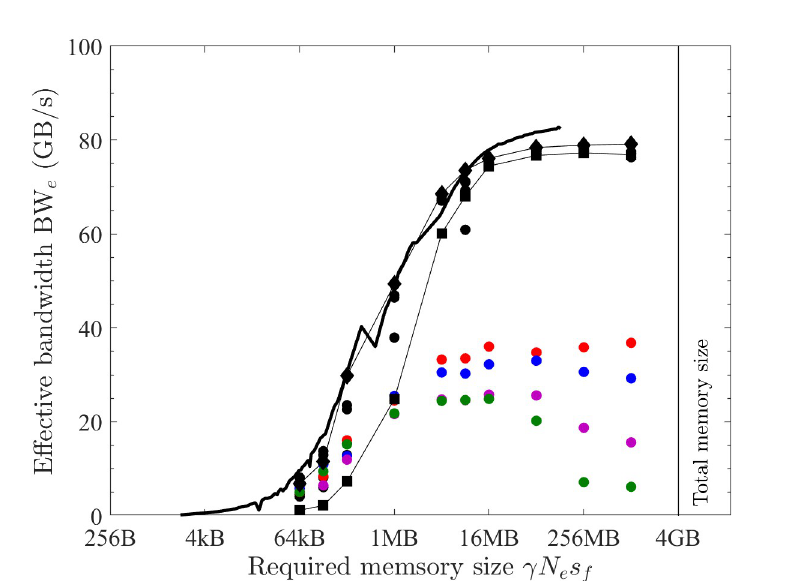
Fig 14. Optimal implementation of COPY2D on the GPU platform of the PC (double precision; solid black line = benchmarked bandwidth; circle symbols = effective bandwidth with different shapes of thread block; black = 1 × 512, 1 × 128, 2 × 256, or 2 × 64; red = 4 × 128; blue = 16 × 32; magenta = 128 × 4; green = 512 × 1; filled diamonds + line = optimal for COPY1D; filled squares + line = XLA).